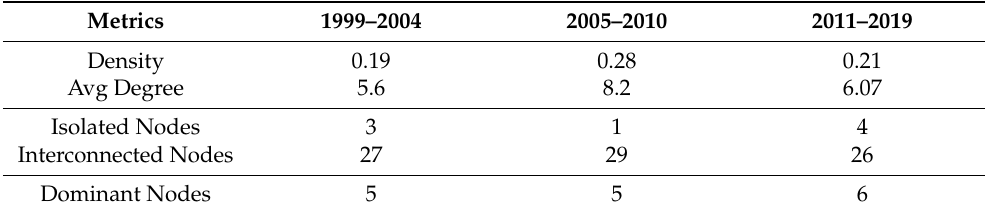
Table 8. Network metrics for 0.8 threshold level on the Exports of Goods and Services (% of GDP)